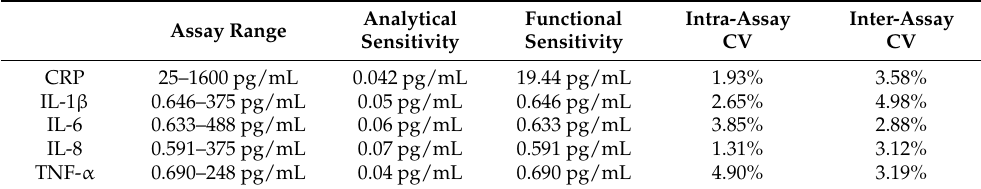
Table 1. Characteristics of assays for inflammatory markers in the current